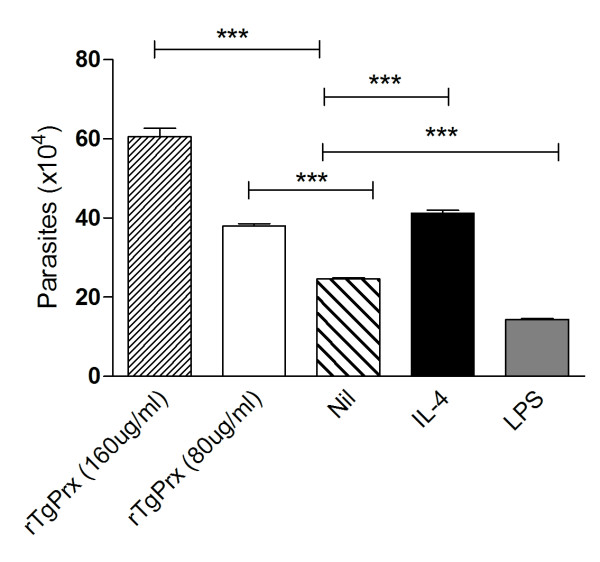
Enhanced parasite replication in rTgPrx treated macrophages. BMDM were pretreated with LPS, IL-4 or rTgPrx overnight prior to infection with T. gondii, MOI 0.2. Data represents quadruplicate counts ± SD, ***p < 0.001.